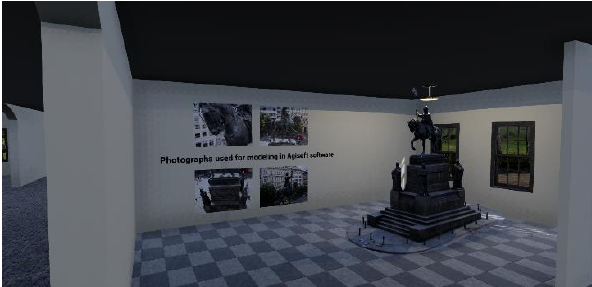
Figure 16. Texture detail – inside